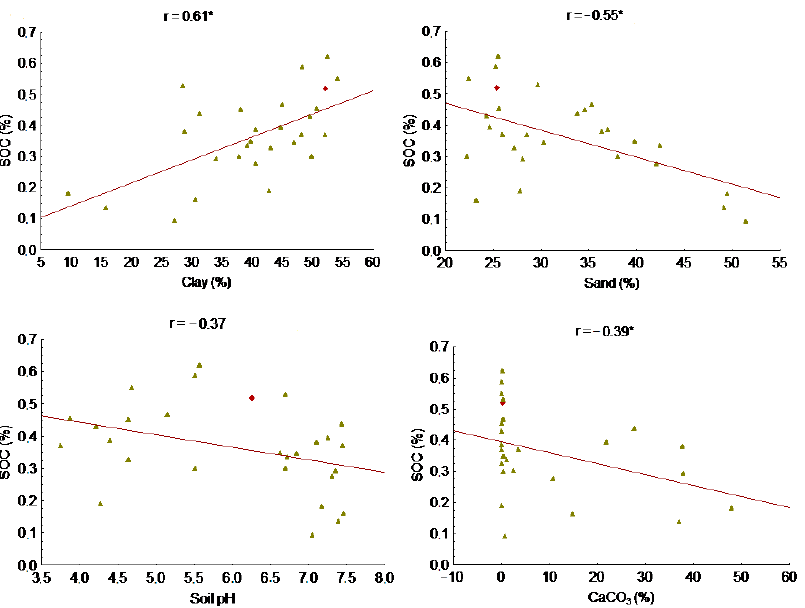
Figure 10. Correlation of SOC with soil properties: clay, sand, CaCO ₃ content and pH value, in subsoil layers (>60 cm) of vineyards; * p < 0.05.